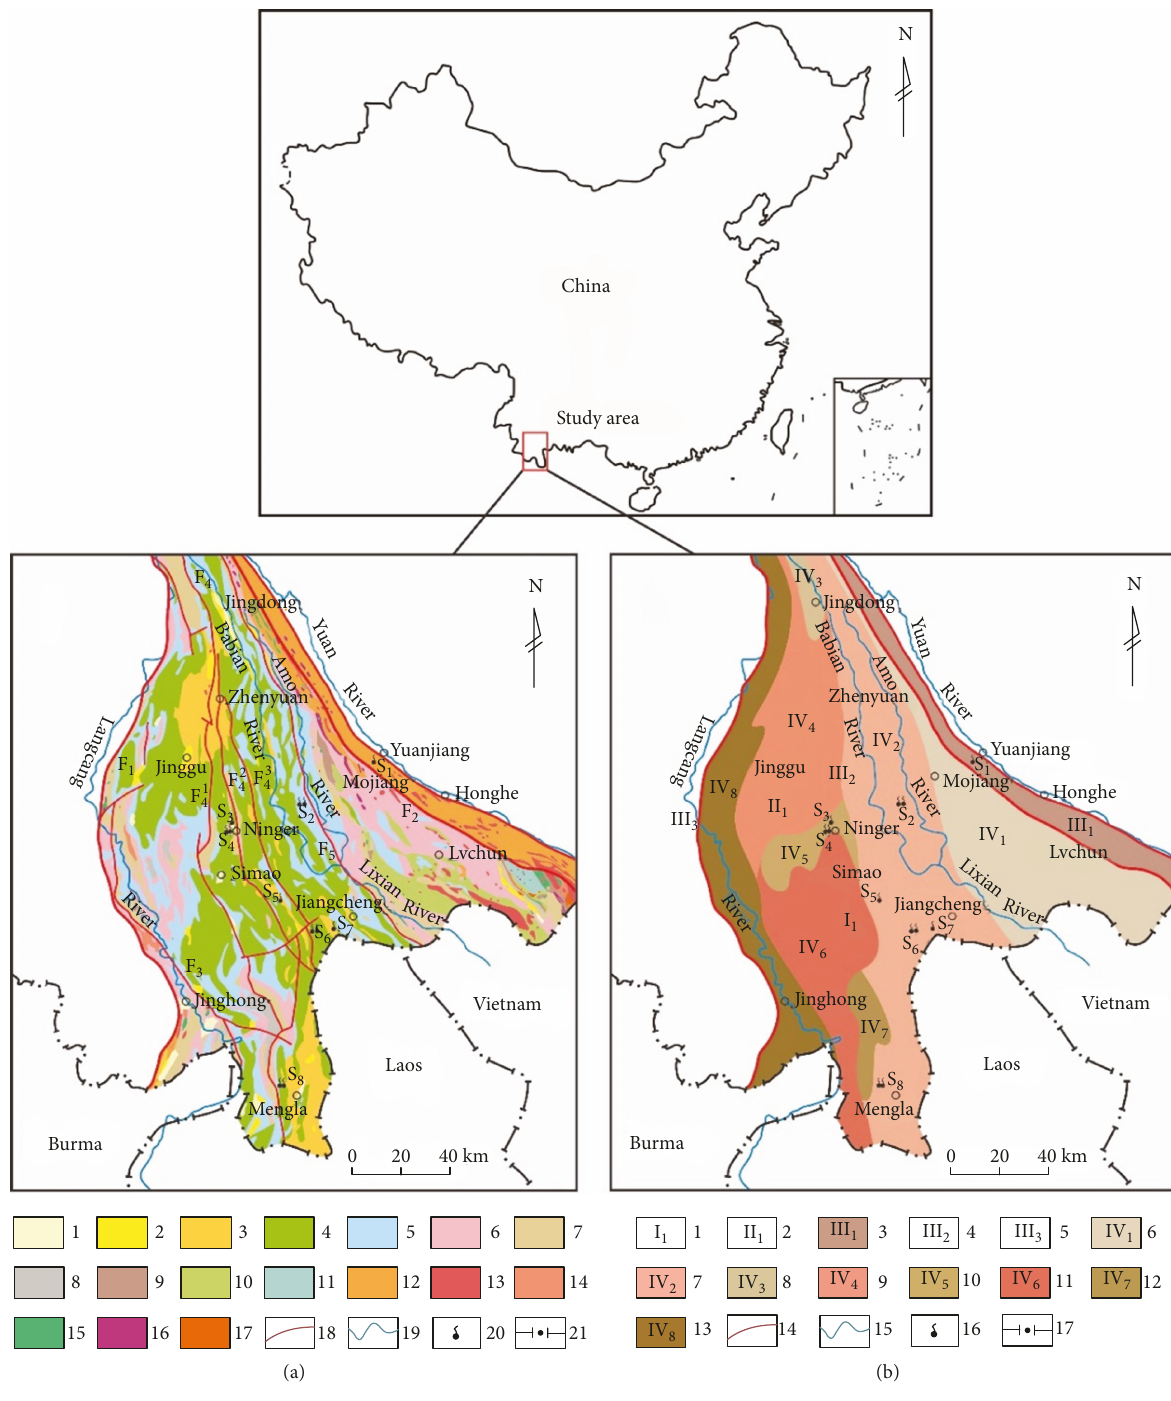
Figure 1: Geological map in the Simao Basin (modi fi ed from [16]). (a) Occurrence of strata and faults in the Simao Basin: 1: Quaternary gravel and clay; 2: Neogene mudstone and fi ne sandstone; 3: Paleogene salt-bearing gompholite and sandstone; 4: Cretaceous quartz sandstone, siltstone, and mudstone; 5: Jurassic mudstone, siltstone, and gypsum; 6: Triassic limestone, shale, mudstone, and siltstone; 7: Permian limestone, mudstone, siltstone, and tu ff ; 8: Carboniferous limestone, shale, and tu ff ; 9: Devonian marl, mudstone, shale, and siltstone; 10: Silurian silicolites, shale, quartz sandstone, and siltstone; 11: Ordovician clastic rocks with limestone; 12: Proterozoic gneiss, granulite, schist, and marble; 13: granite; 14: quartz monzonite; 15: gabbro; 16: magnesian ultrama fi c rock; 17: quartz syenite; 18: fault; 19: river; 20: spring; 21: international boundary. (b) Tectonic division in the Simao Basin: 1: Sanjiang fold system; 2: Lancangjiang- Ailaoshan fold belt; 3: Ailaoshan uplift; 4: Simao rift valley; 5: Lancangjiang uplift; 6: Mojiang margin uplift; 7: Jiangcheng depression; 8: Wuliangshan uplift; 9: Jinggu depression; 10: Pu ’ er-Dehua uplift; 11: Dadugang depression; 12: Mengyuan uplift; 13: